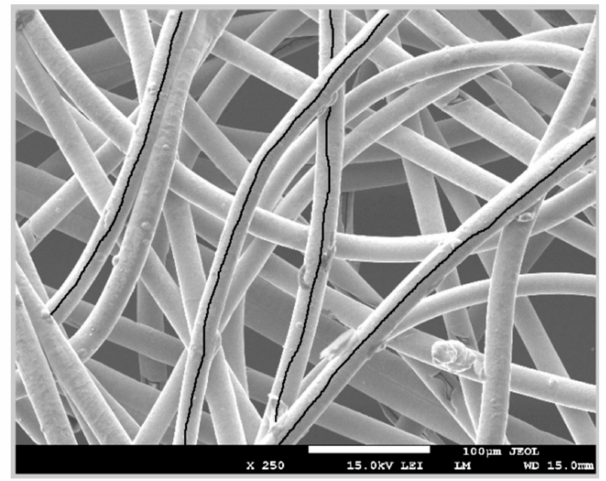
Figure 3. Selection of the fiber lengths by